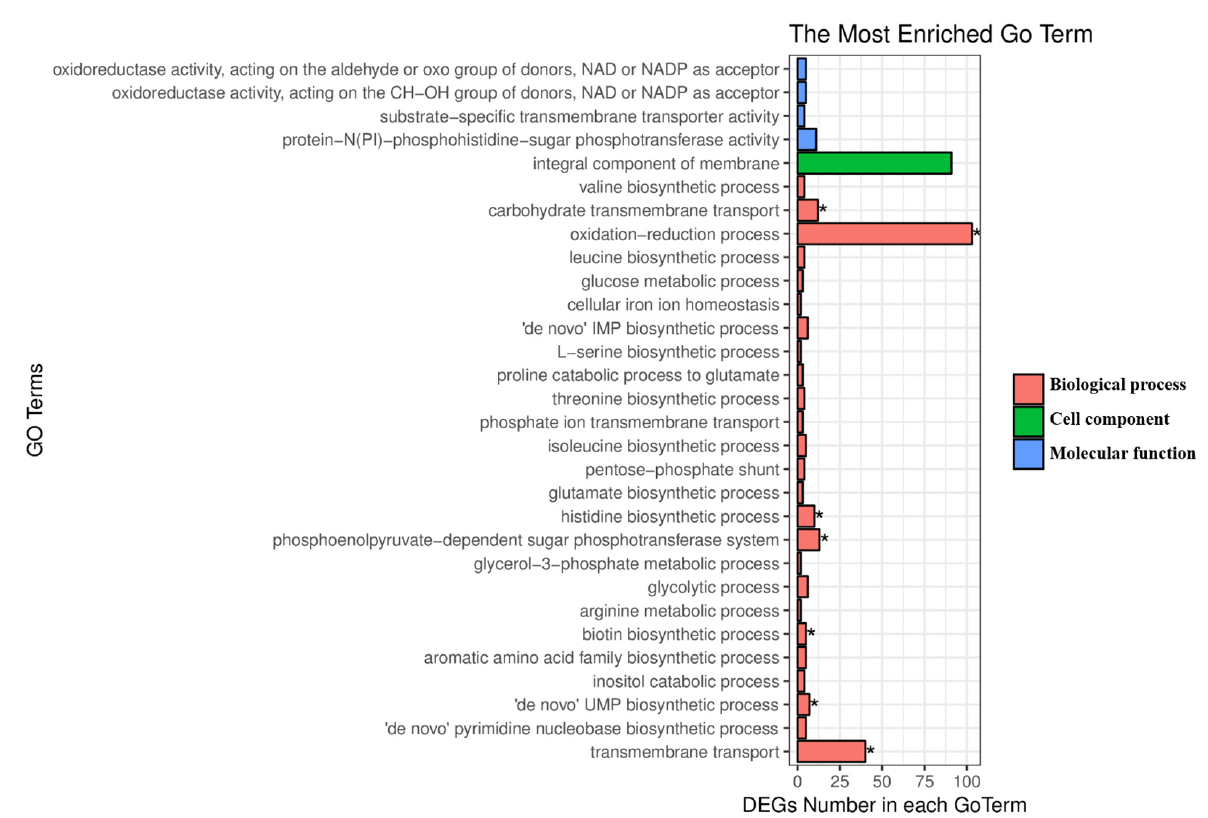
Figure 3. The GO classification of the differentially expressed genes by Bacillus velezensis CMT-6 at the higher DO concentration (* represents genes with significantly enriched GO terms ( p -value ≤ 0.05).